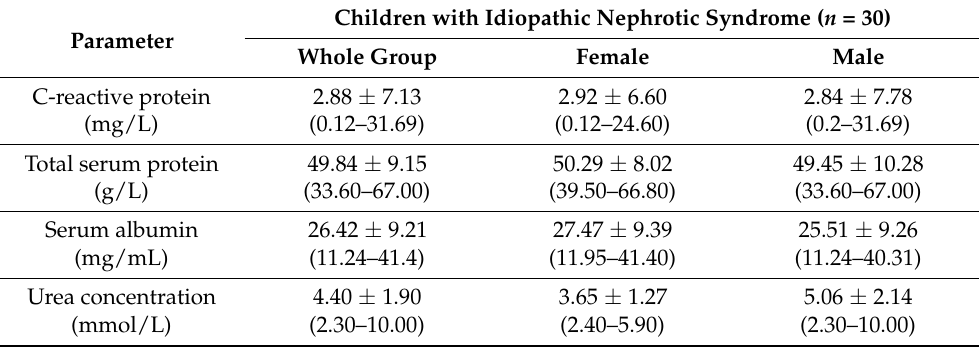
Table 2. Characteristics of the study group and their selected laboratory